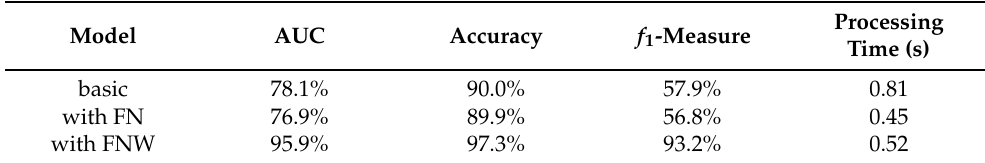
Table 6. Combining results of CMB on four DMD dataset.